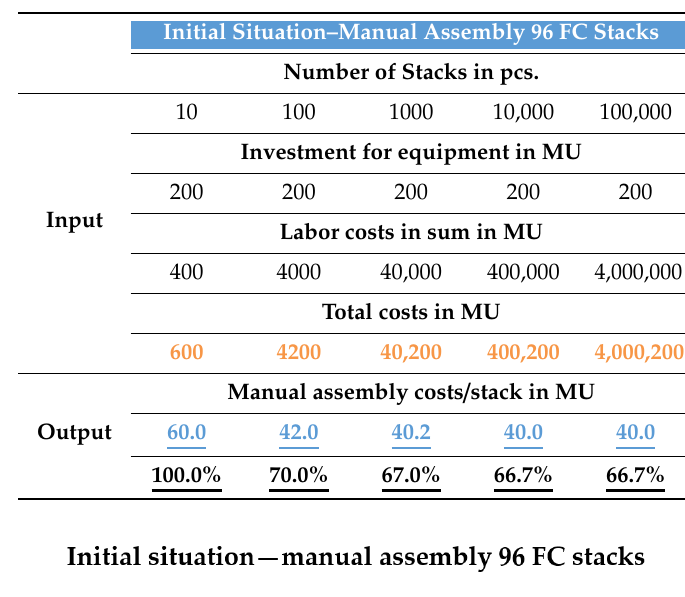
Table 2. Baseline—manual assembly—production time 40 h / stack with one operator.